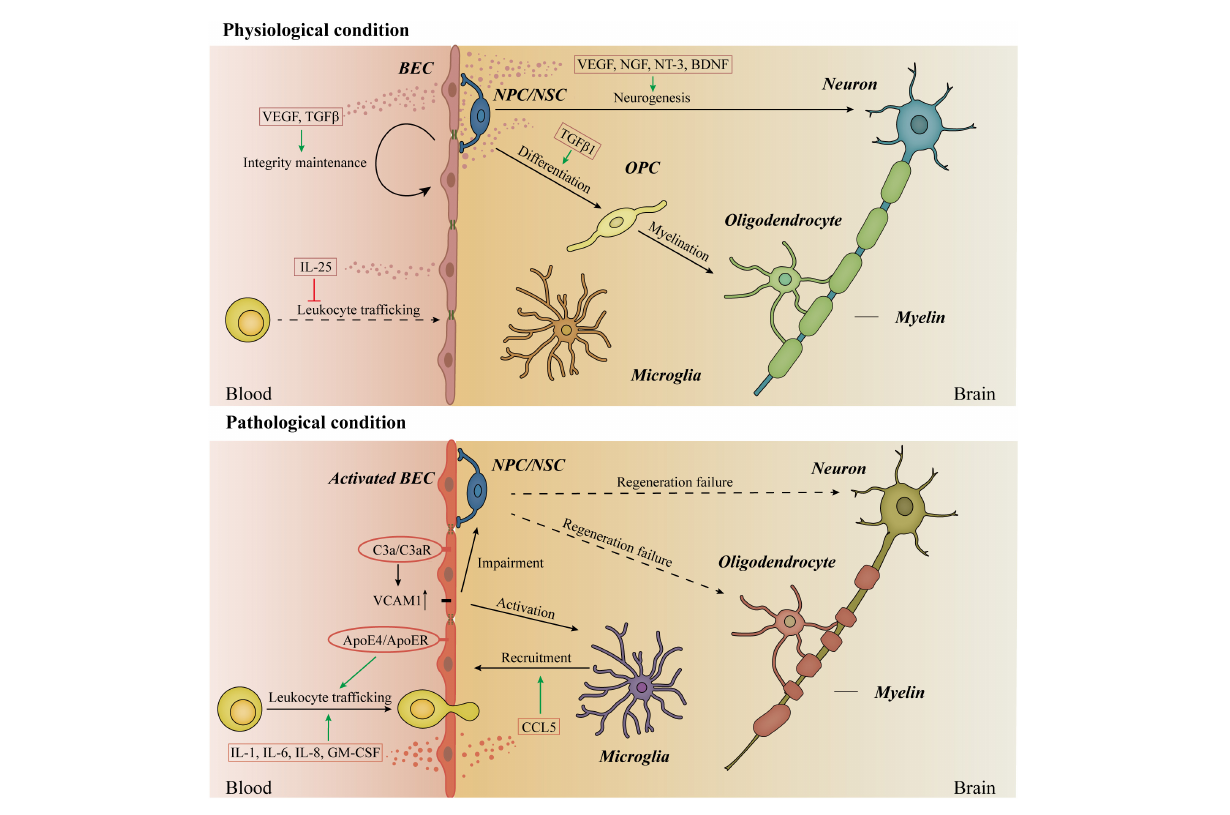
FIGURE2 Immune responses and stem cell activities in physiological and pathological conditions. Under physiological conditions, BECs secret VEGF and TGF β in the autocrine way to maintain the integrity of BBB. Moreover, IL-25 released from BECs inhibits leukocyte trafficking in physiological conditions. In the brain, BECs secret neurotrophic factors to regulate the proliferation, differentiation, and migration of NSCs, promoting neurogenesis. BEC-derived TGF β 1 regulates the differentiation of OPCs from NPCs. However, the exact role of BECs in the myelination process is still unknown. In disease states, activated BECs secret IL-1, IL-6, IL-8, and GM-CSF to promote the trafficking of leukocytes across BBB. Periparial ApoE4 activates BECs and promotes leukocyte trafficking across BBB. The upregulation of VCAM1 in BECs is regulated by the binding of C3a and C3aR in BECs, activating the microglia and impairing the NSC activities. The chemokine CCL5 released by BECs recruits the resident brain microglia. Considering the crucial roles of BECs in neurogenesis and myelination, the studies of the contents and functions of BECs secretions in the regeneration failure of neurons and oligodendrocytes can provide insights into the pathophysiological process of neurodegenerative diseases. BECs, barrier type brain endothelial cells; NSCs, neural stem cells; TGF β , transforming growth factor beta; OPCs, oligodendrocyte precursor cells; NPCs, neural progenitor cells; SHH, sonic hedgehog; VEGF, vascular endothelial growth factors; BBB, blood–brain barrier; GM-CSF, granulocyte-macrophage colony-stimulation factor; ApoE4, apolipoprotein E4; VCAM1, vascular cell adhesion molecule